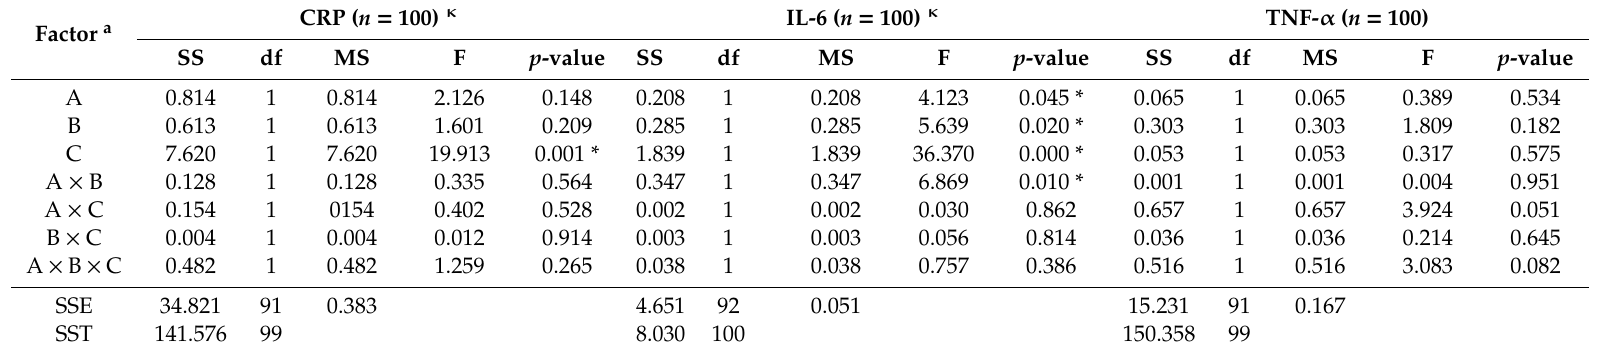
Table 5. Three-way interaction analysis by the studied inflammatory biomarkers.